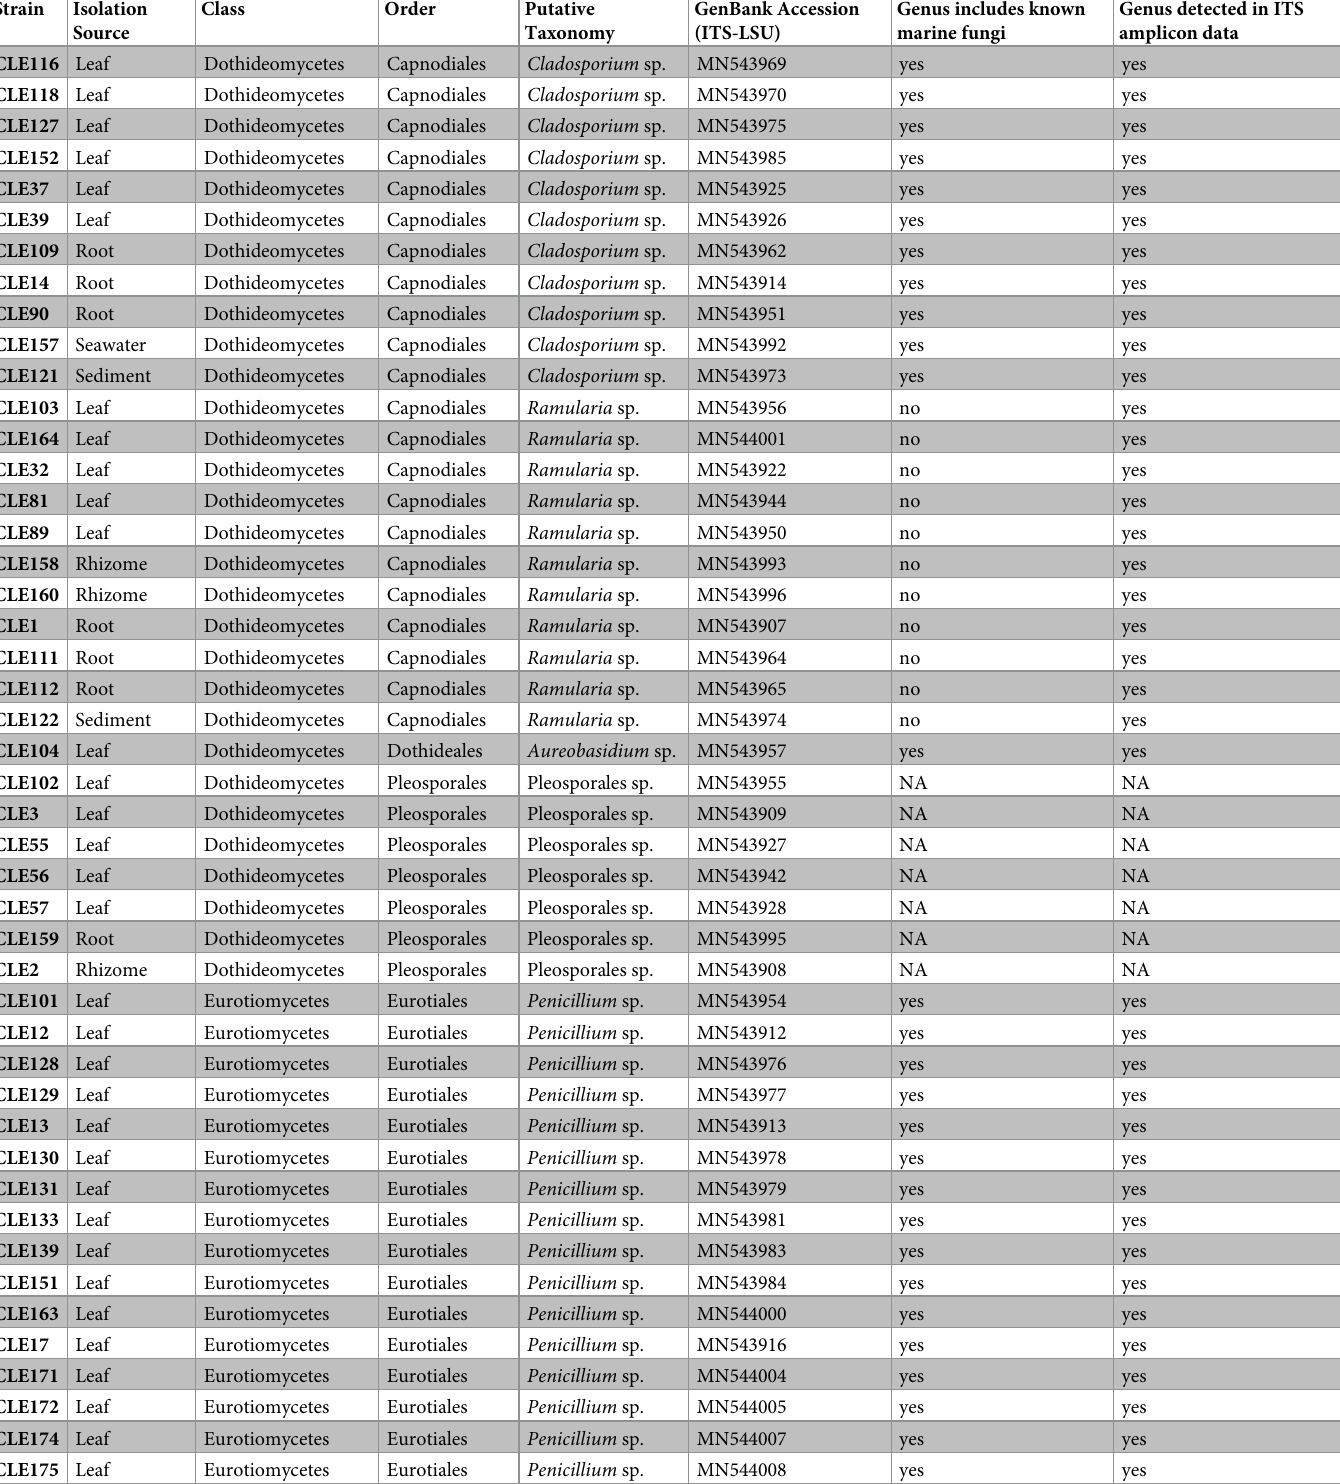
Table 1. Fungi isolated from the seagrass, Zostera marina